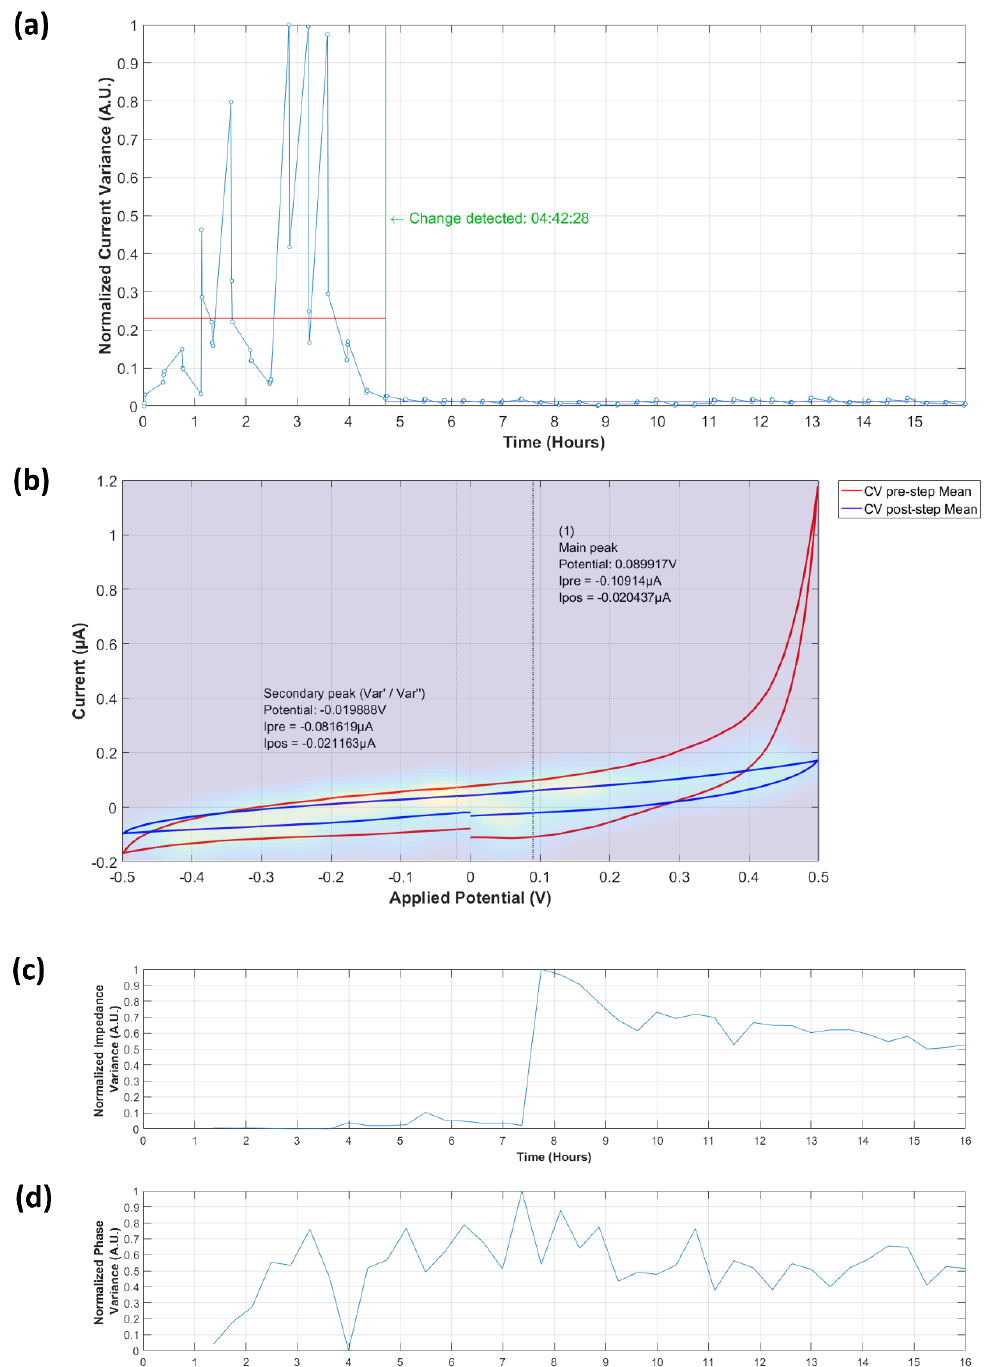
Figure A8 . Recorded electrochemical response of early electrode damage without a colonization event. ( a ) Normalized current variance vs. time. Detected current peaks are indicated (peaks from variance to its first derivative ratio are indicated as Var/Var’, peaks from first derivative to second derivative ratio are indicated as Var’/Var’’. The current values at each peak are indicated for the mean before colonization event as I pre and for the mean after colonization event as I pos ). ( b ) Recorded CV with calculated peaks and heatmap of detected peaks, where yellow represents a high concentration, and dark blue no peak. ( c ) Normalized impedance variance vs. time. ( d ) Normalized phase variance vs. Time. This incident was registered mainly due to wear-off of the electrodes after repeated use. An increase of the current normalized variance and the impedance normalized variance, with no indicative change in the phase normalized variance, were attributed to an increase in the overall microsystem resistance while no faradaic effect was present.